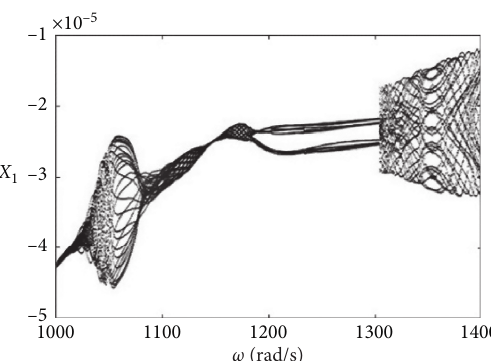
Figure 10: Bifurcation diagram of rotor with k